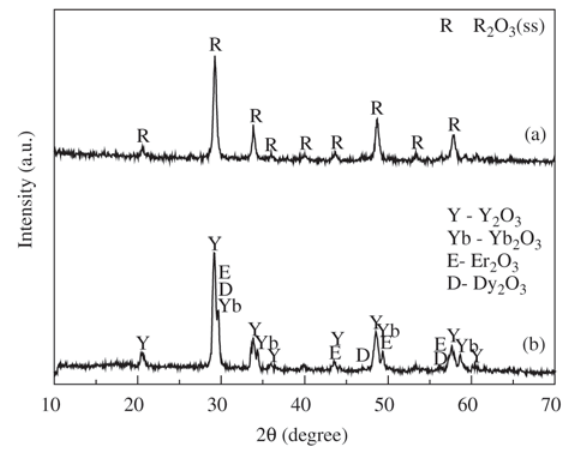
Figure 1. X-ray diffraction patterns of: a) solid solution rare